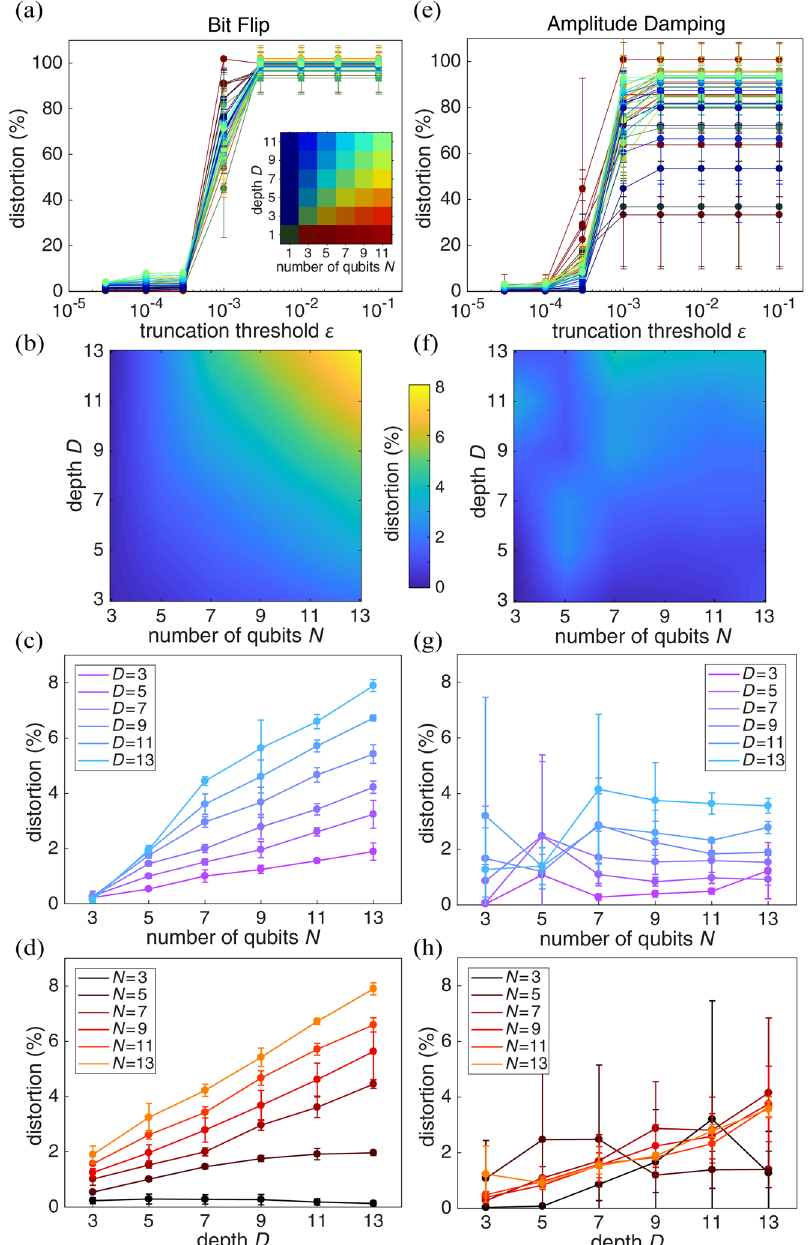
Fig. 7 Noise type benchmarking: error. Benchmarking of error under bit fl ip (left column) and amplitude damping (right column) with p = 0.1%. a , e Distortion as a function of the number of qubits, circuit depth, and ϵ . (Inset) The colormap for the curves, indicating their their sizes of quantum circuit. b , f Distortion as a function of qubit number, circuit depth with ϵ = × 10 − 4 . c , g Horizontal line cut of b and f . d , h Vertical line cut of b and f . The error bars are standard-deviation-calculated across a set of